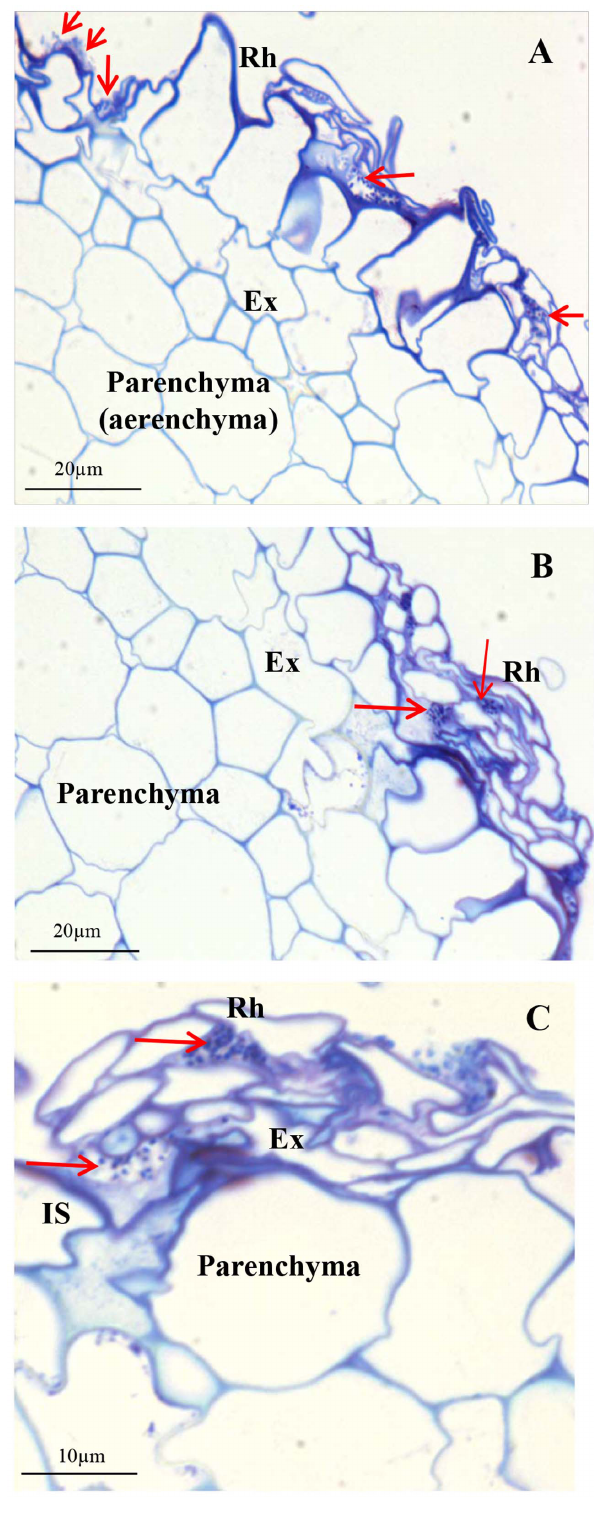
Figure 6. Light micrographs of transversal sections of rice roots inoculated with Azoarcus sp. CIB (pSEVA23GFP) cells and incubated for 7 days. Colonization of root surface and intercellular spaces under rhizodermis and the first layer of exodermis (A); intercellular colonization of the second and third layers of the exodermis (B); intercellular colonization of the deeper layer of the exodermis, just in contact with the parenchyma (C). IS,